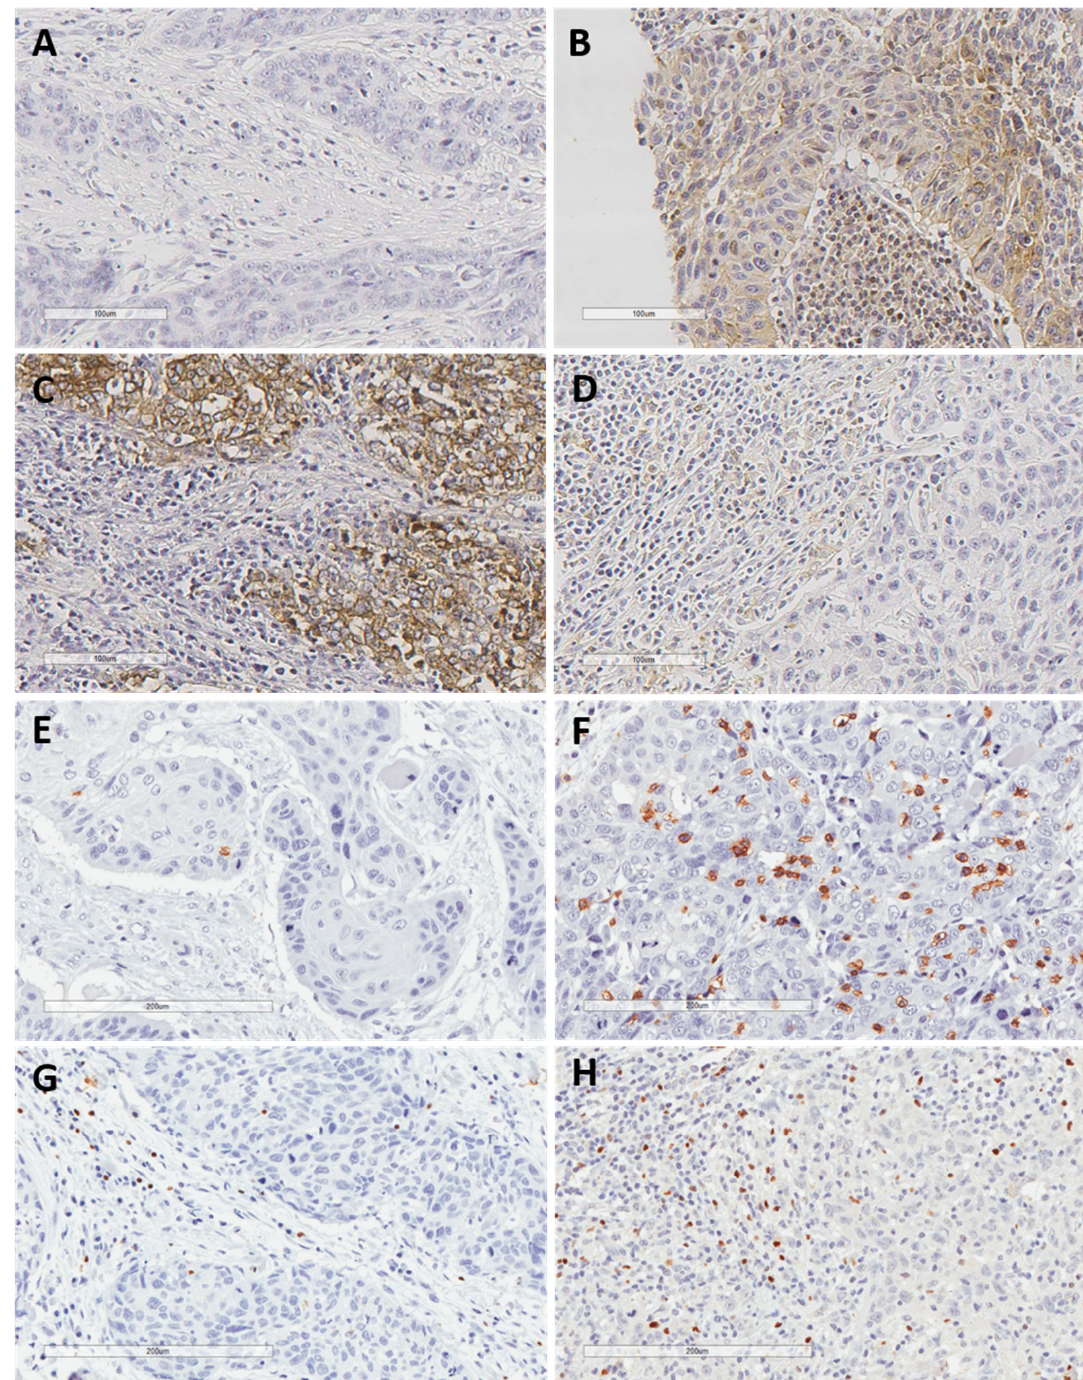
Figure 1. Representative examples of negative PD-L1 expression in both tumor and the surrounding immune cells ( A ), positive PD-L1 expression in both tumor and stromal immune cells ( B ), positive PD-L1 expression in tumor cells but not in surrounding immune cells ( C ), positive PD-L1 expression in immune cells but not in tumor cells ( D ), low and high density of CD8+ TIL ( E , F ), and low and high density of FOXP3+ TIL ( G , H ). Original magnification × 200. There were no differences in the mean density of TILs between the patient subgroups of responders and non-responders to ICT (Table 3). However, the mean ratio between CD8+ TIL and FOXP3+ TIL density was significantly higher in the subgroup of responders to ICT ( p =